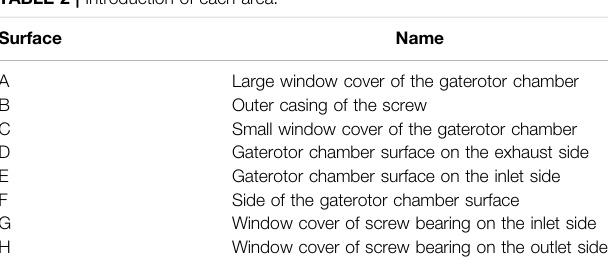
TABLE 2 | Introduction of each area.